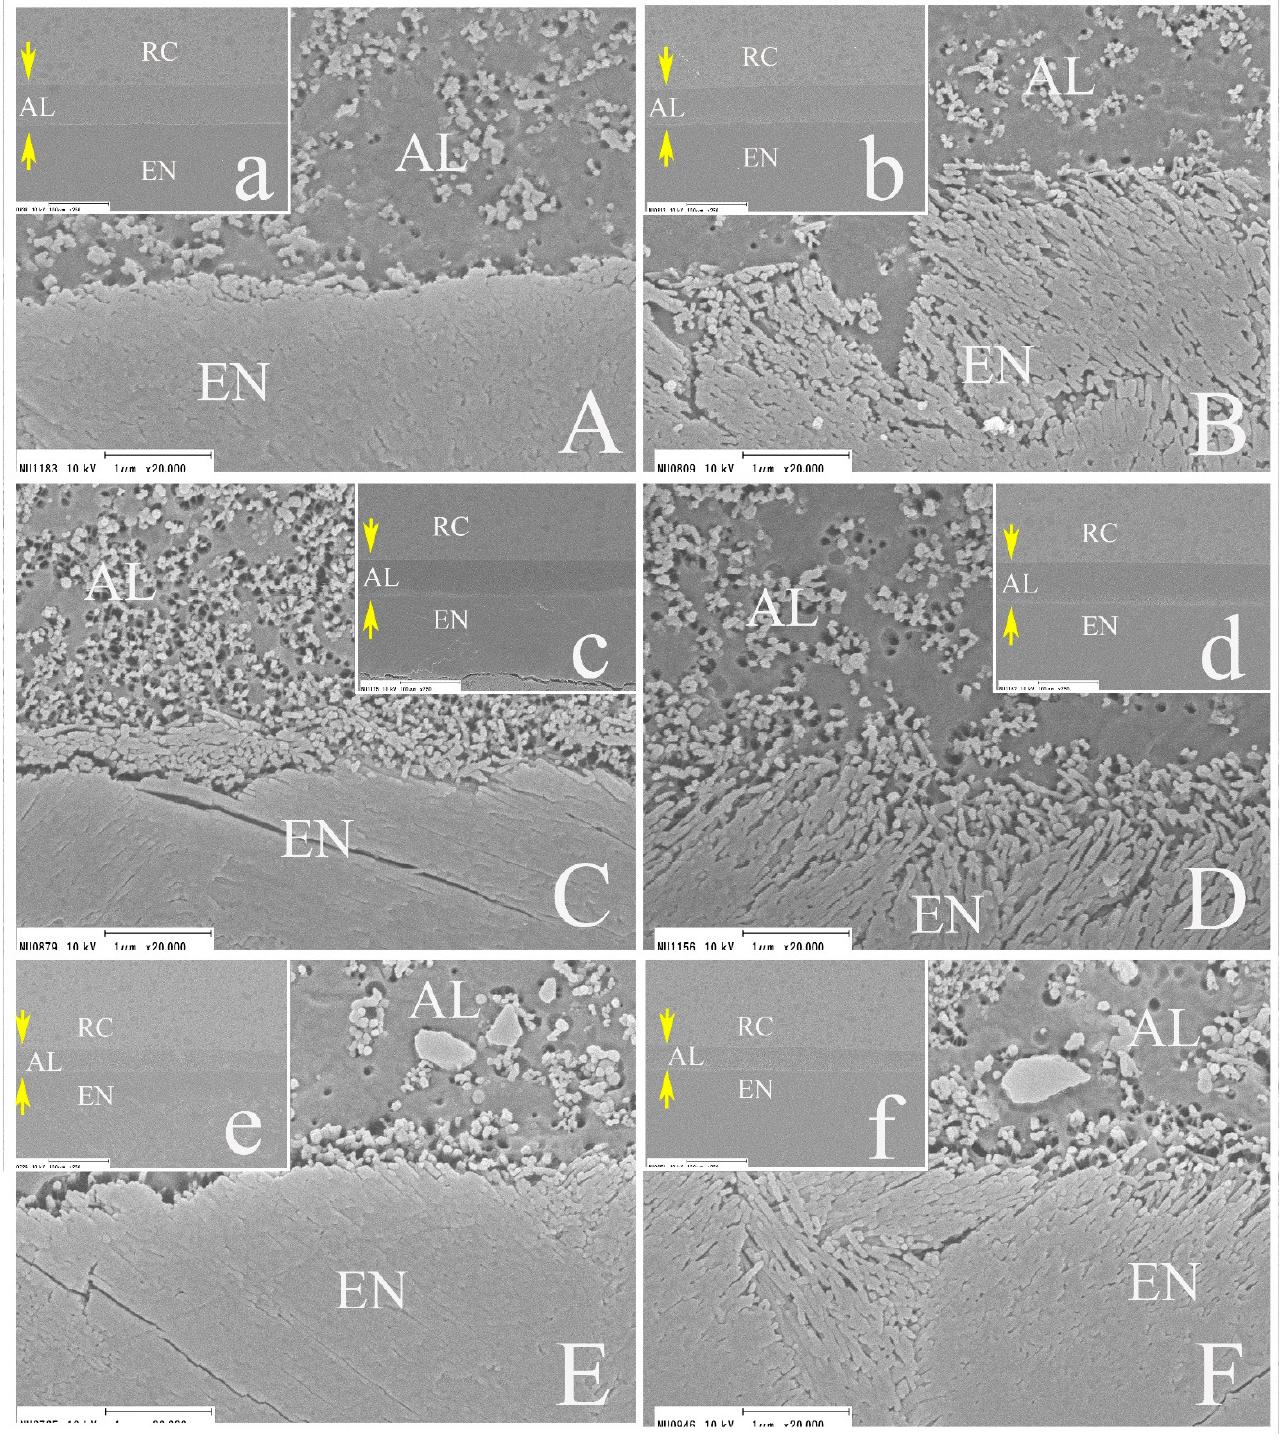
Figure 8. Representative SEM images of resin/enamel interfaces (Group II). ( A ) CS in SE mode (×20,000, ×1000). ( B ) CS in ER mode (×20,000, ×1000). ( C ) GU in SE mode (×20,000, ×1000). ( D ) GU in ER mode (×20,000, ×1000). ( E ) OX in SE mode (×20,000, ×1000). ( F ) OX in ER mode (×20,000, ×1000). AL: adhesive layer, EN: enamel, RC: resin composite. The yellow arrows indicate the adhesive layer.